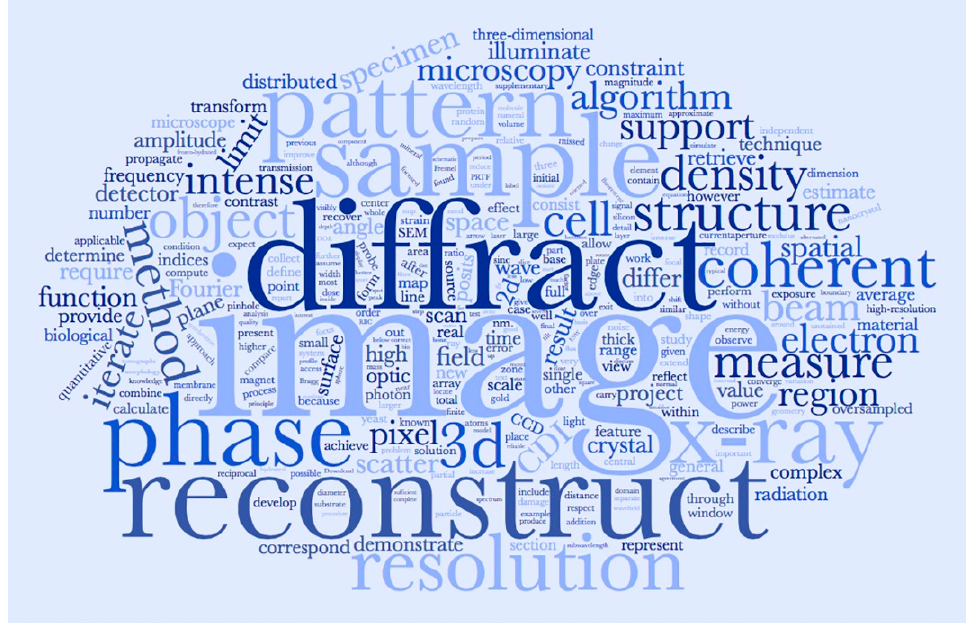
Figure 1 . Word cloud of synchrotron-based coherent diffraction imaging published research papers. About 50 widely-read published papers were downloaded. These papers are published during the last 18 years since the first coherent diffraction imaging experiment was conducted successfully in 1999. The main text of the papers was analyzed by open python codes. The frequency of each meaningful word was calculated and then demonstrated by different size and colors. The bigger the size means the larger the frequency. The image shows that reconstruction, sample, phase and resolution are the most used terms for the past 18 years of coherent diffraction imaging research. At the same time, structure, intensity and radiation have also been key topics for biological imaging since 1999. (Original datas were collected from References [24,31,32,38,42–87]. Figure was generated under the help of